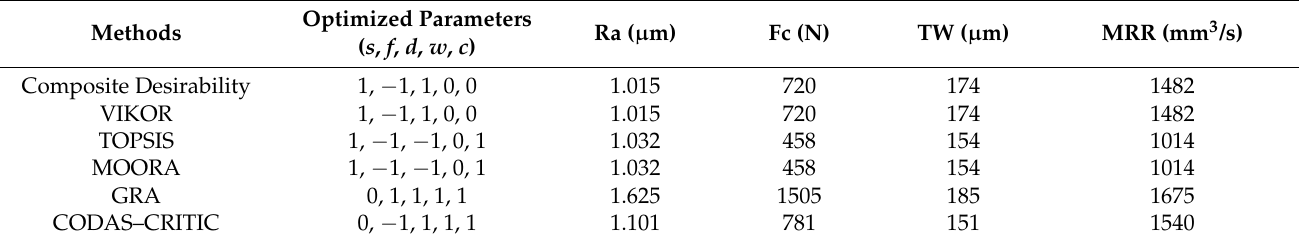
Table 14. Comparison of CODAS–CRITIC with other